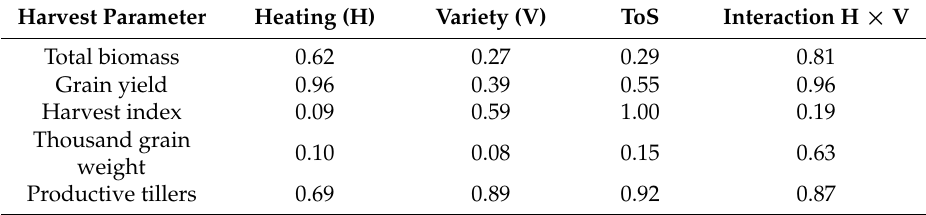
Table 3. p -value result from the linear mixed model associated with heating, variety, and ToS in 2017. Harvest Parameter Heating (H) Variety